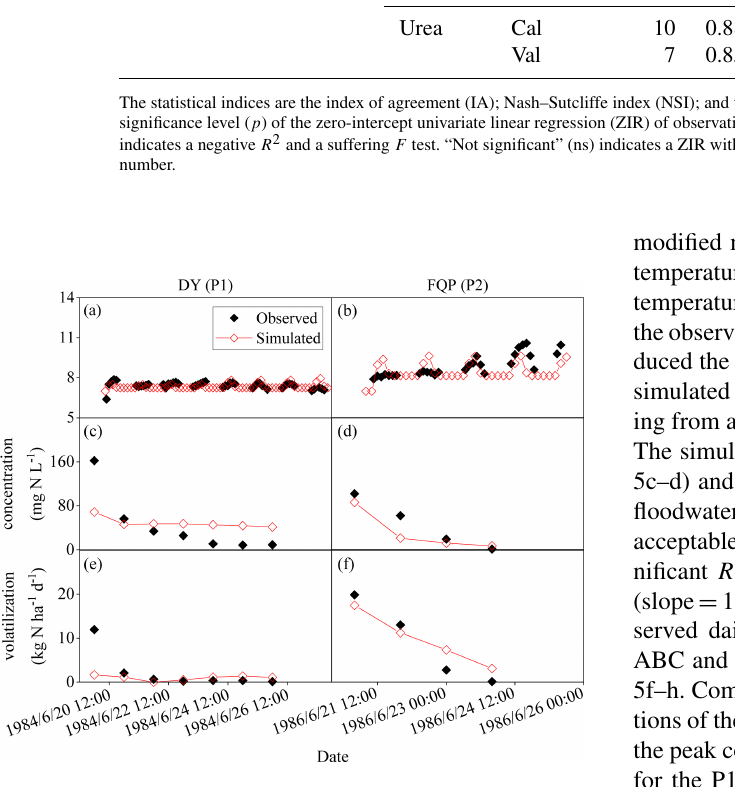
Figure 3. Observed and simulated pH and ammonium concentra- tions of floodwater and daily ammonia volatilization from the am- monium carbonate application for DY and FQP. The definitions of the case codes refer to Table 2. The sites are Danyang (DY) and Fengqiu with rice paddy fields